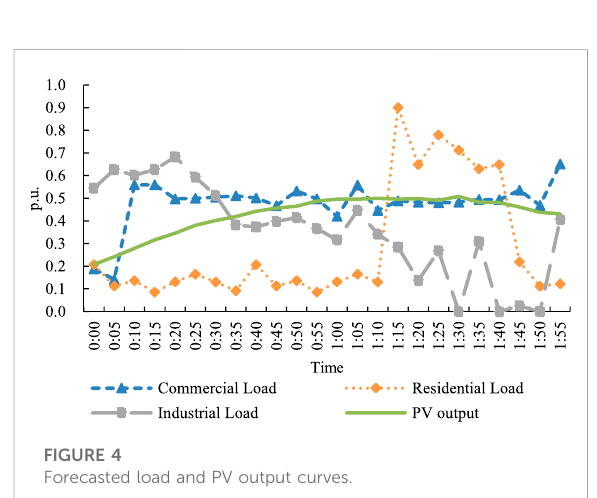
FIGURE 4 Forecasted load and PV output curves.